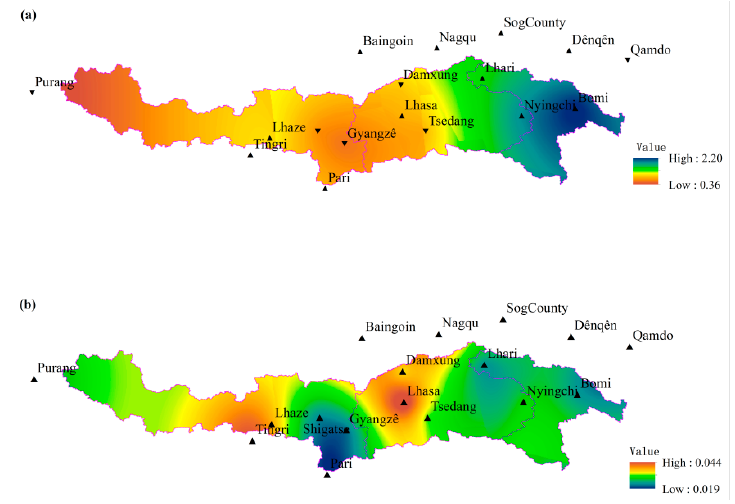
Figure 2. Sen’s slope of ( a ) the annual average precipitation; ( b ) annual average air temperature.